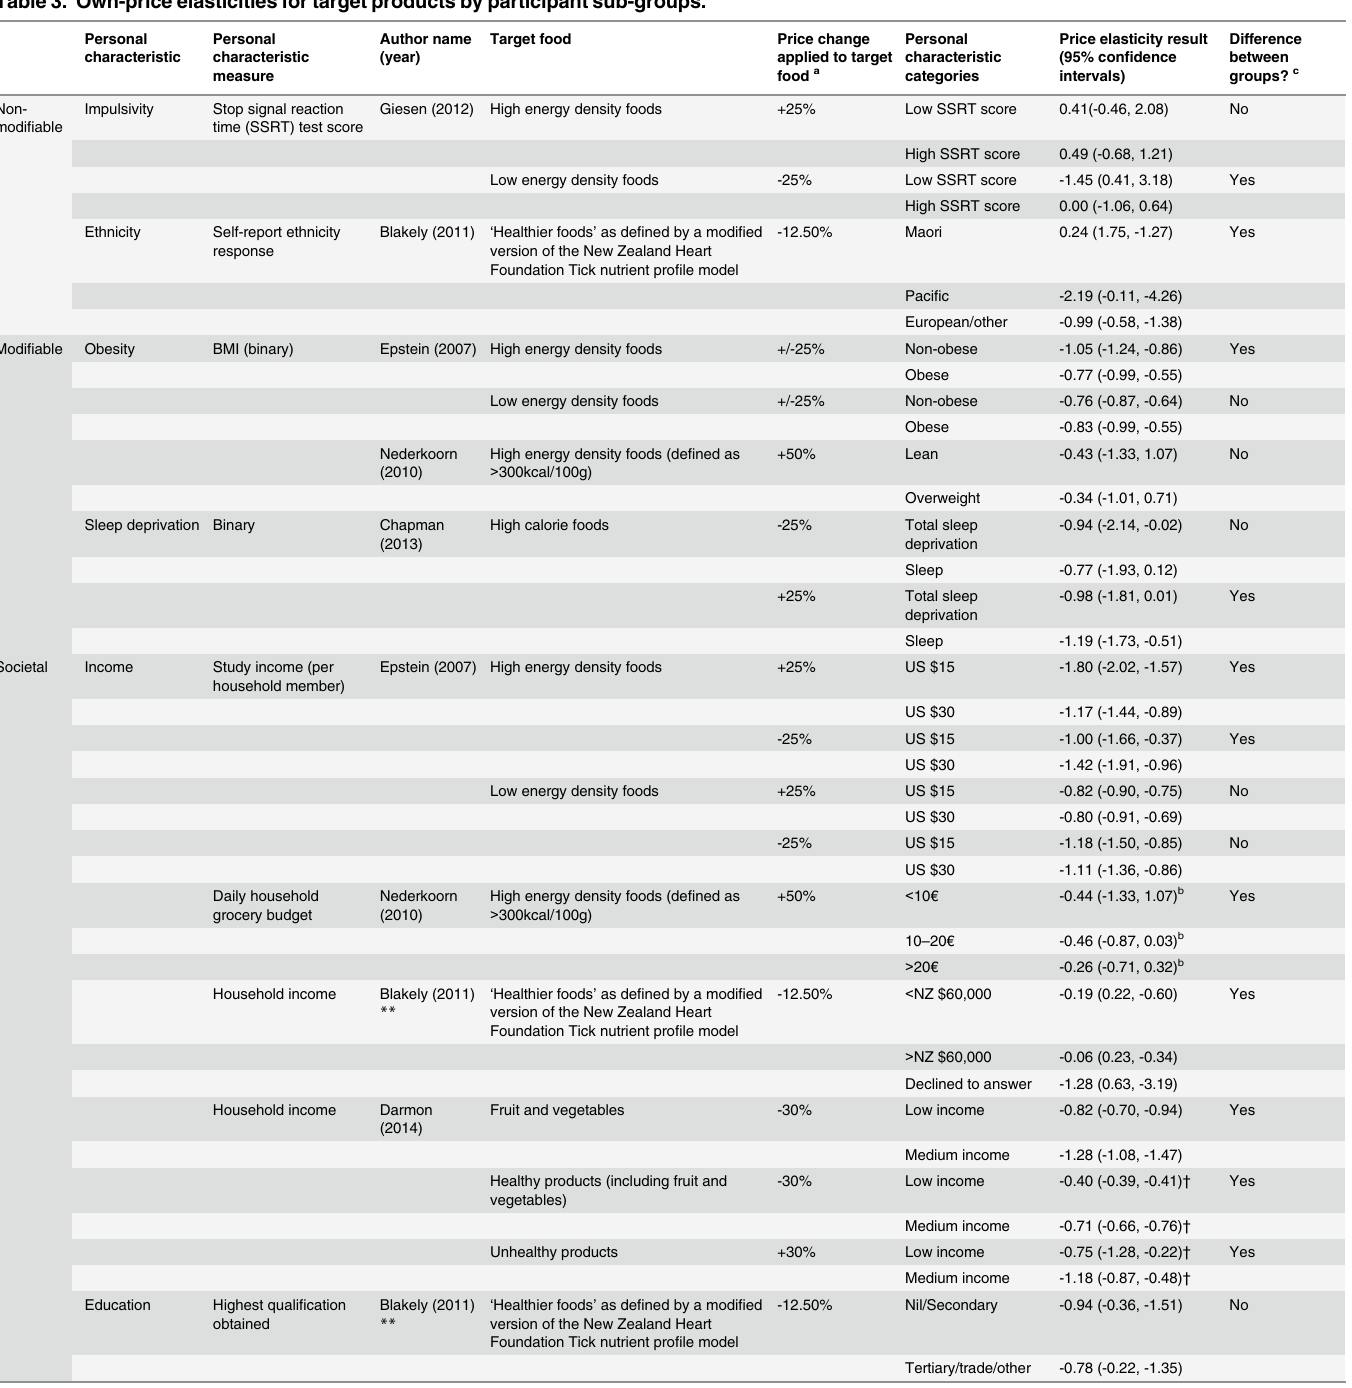
Table 3. Own-price elasticities for target products by participant